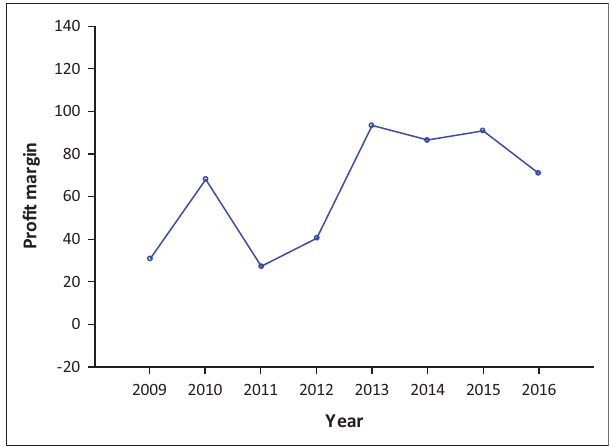
FIGURE 2: Fisher least significant difference results for profit TABLE 4: Pairwise correlations of sustainable growth rate components with Tobin Q for the pre-real estate investment trust and real estate investment trust periods. Variable